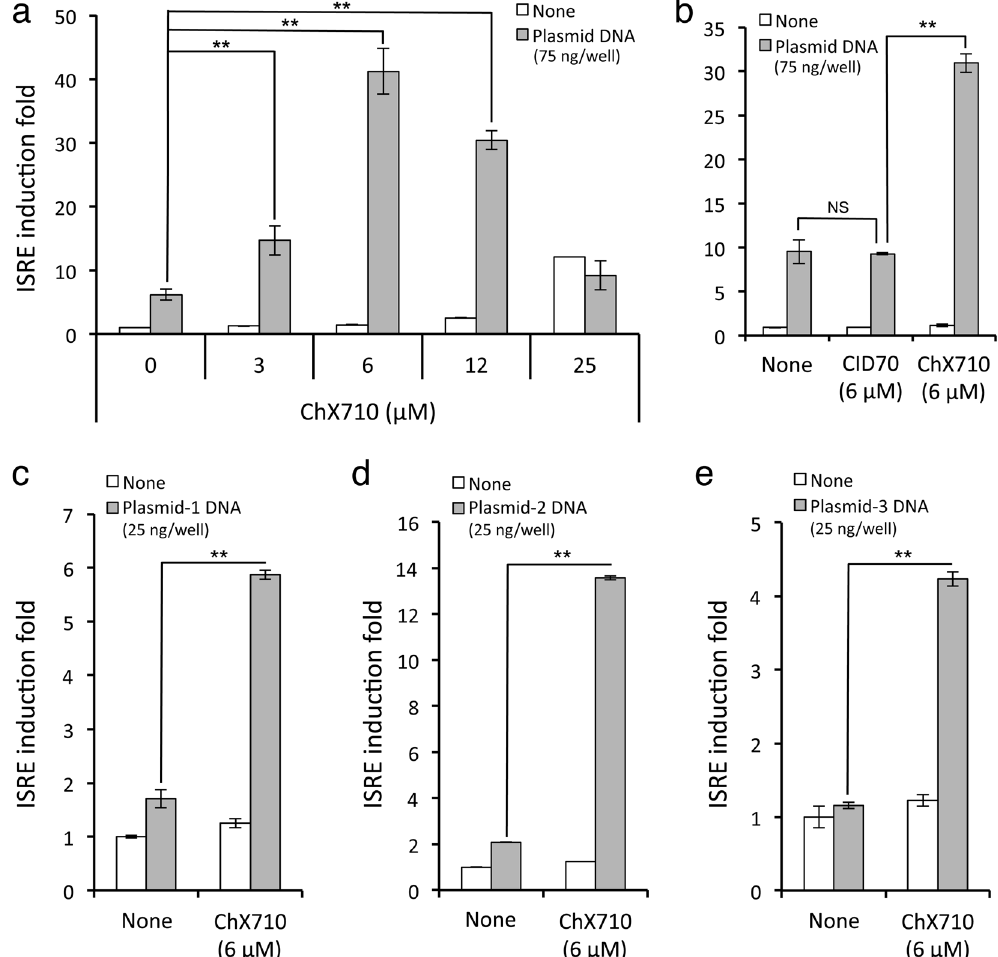
Figure 6. ISRE induction by plasmid DNA transfection is boosted in ChX710-treated cells. ( a ) ISRE-luciferase reporter cells were transfected with 75 ng/well of plasmid DNA (pCiNeo-3xFlag-GW), and cultured at 4 × 10 4 cells/well in 96-well plates with DMSO alone or increasing concentrations of ChX710. After 24 hours of incubation, luciferase induction was determined. ( b ) Same experiment as in ( a ) but cells were treated with 6 μ M of ChX710 or CID70, an inactivate analog of ChX710. ( c ) Same experiment as in ( a ) but cells were transfected with 25 ng/well of pCiNeo-3xFlag-GW (Plasmid-1), pTK-Renilla (Plasmid-2) or pDONR207 (Plasmid-3), and stimulated with ChX710 at 6 μ M. Experiments were performed in duplicate, and data represent means ± SD. *** P < 0.01 as calculated by two-way ANOVA and Bonferroni’s post hoc test ( a and b ) or Student’s t test ( c